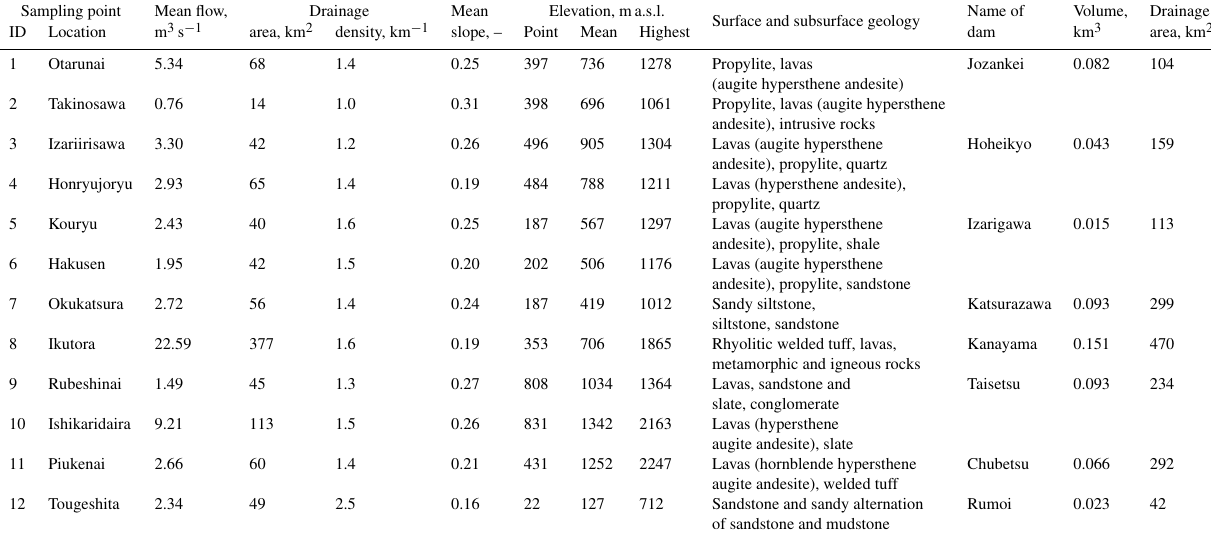
Table 1. Characteristics of 12 investigated headwater catchments in Hokkaido, Japan. Sampling